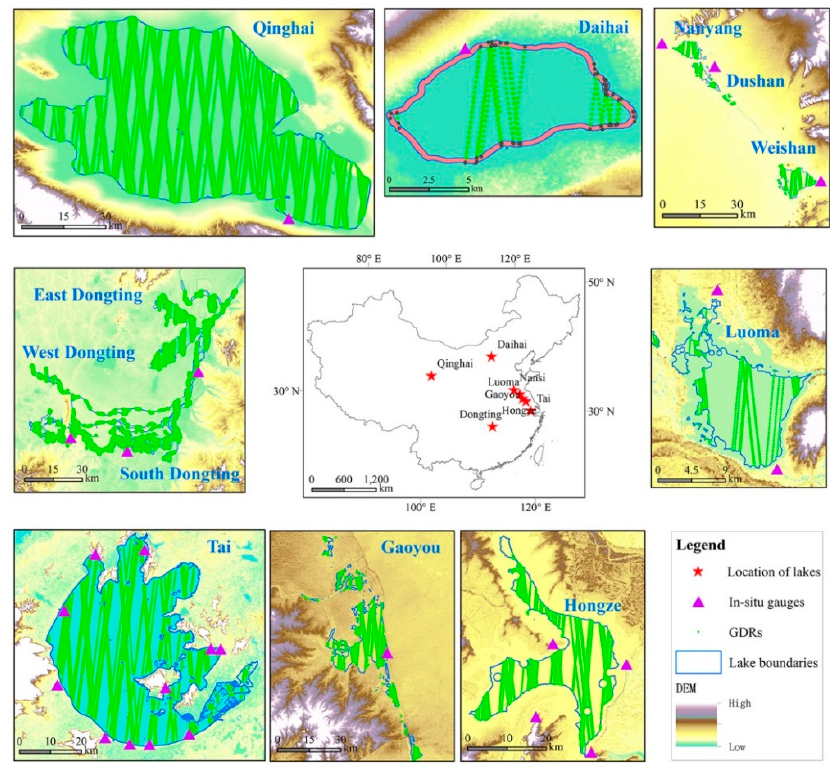
Figure 1. The locations of the studied lakes, in situ gauges, and CryoSat-2 geophysical data record (GDR) tracks.